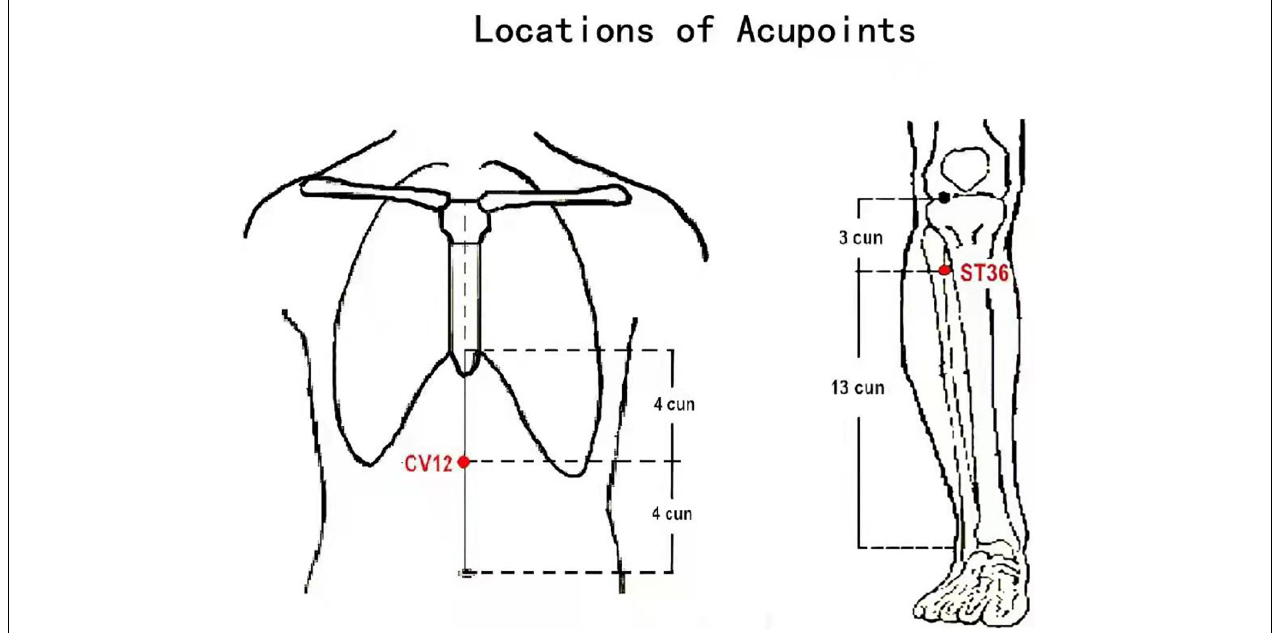
FIGURE 1 | Acupoint locations of He-Mu point combination. Zhongwan (CV12): on the anterior median line of the upper abdomen, 4 cun above the navel. Zusanli (ST36): on the anterior lateral side of the shank, 3 cun below Dubi (ST35), one horizontally placed finger distance lateral to the anterior border of the tibia.